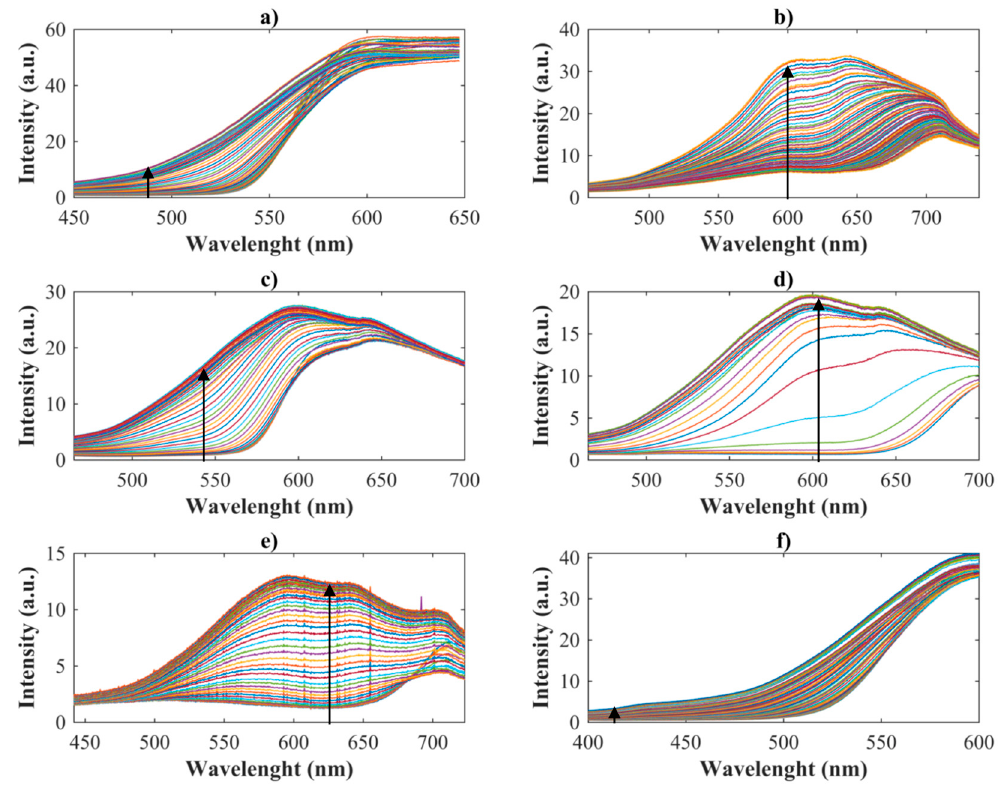
Figure 2. Spectrum recorded of each dye as a function of time. ( a ) OP2, ( b ) RB, ( c ) PC, ( d ) PN, ( e ) PB, ( f ) PY.